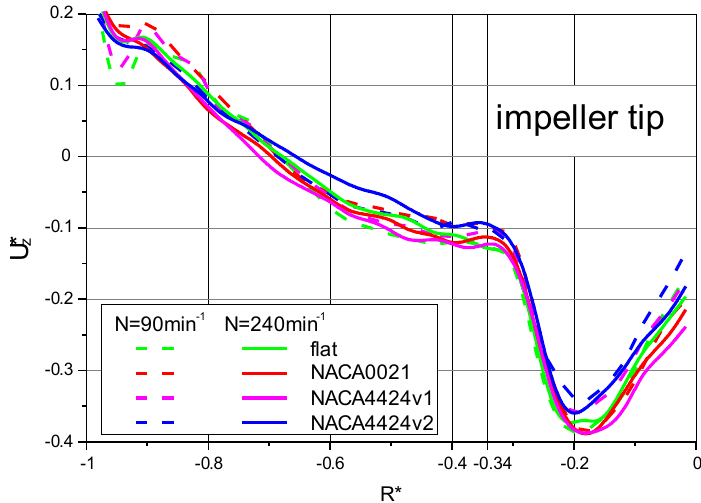
Figure 10. Axial dimensionless velocity profiles 1 mm below the impeller.